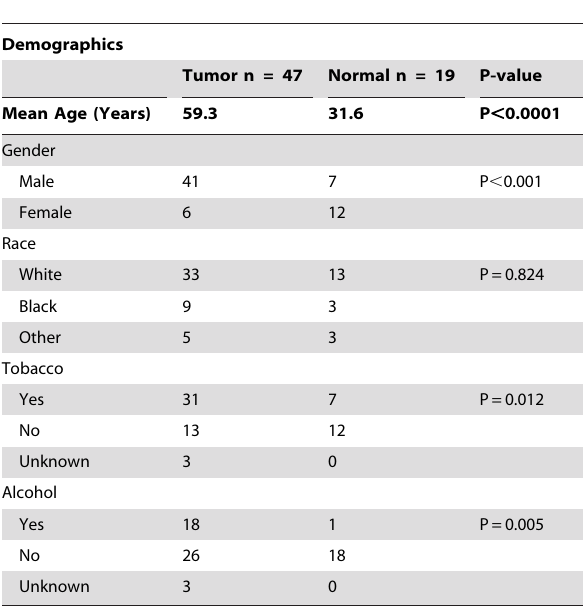
Table 1. Demographic characteristics of discovery tumor and UPPP normal tissue samples.